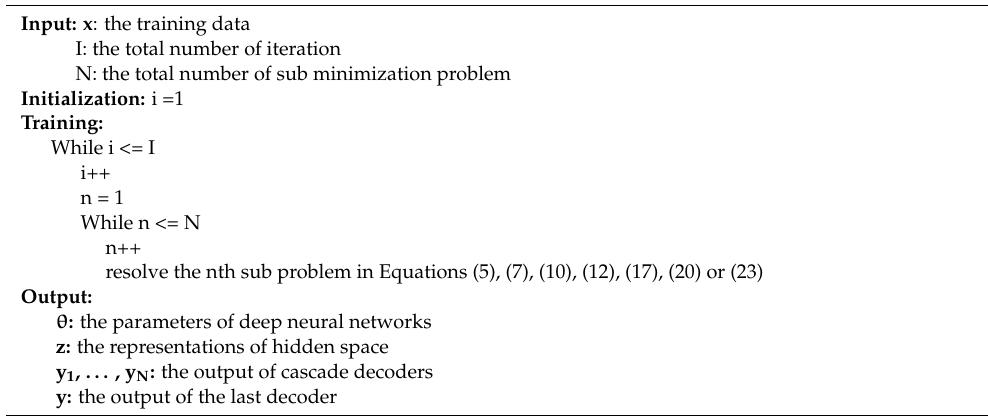
Algorithm 1: The pseudo codes of cascade decoders-based